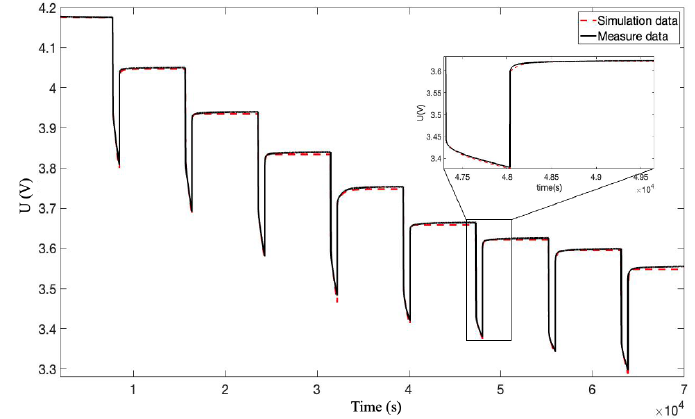
Figure 4. Pulse discharge test and parameter